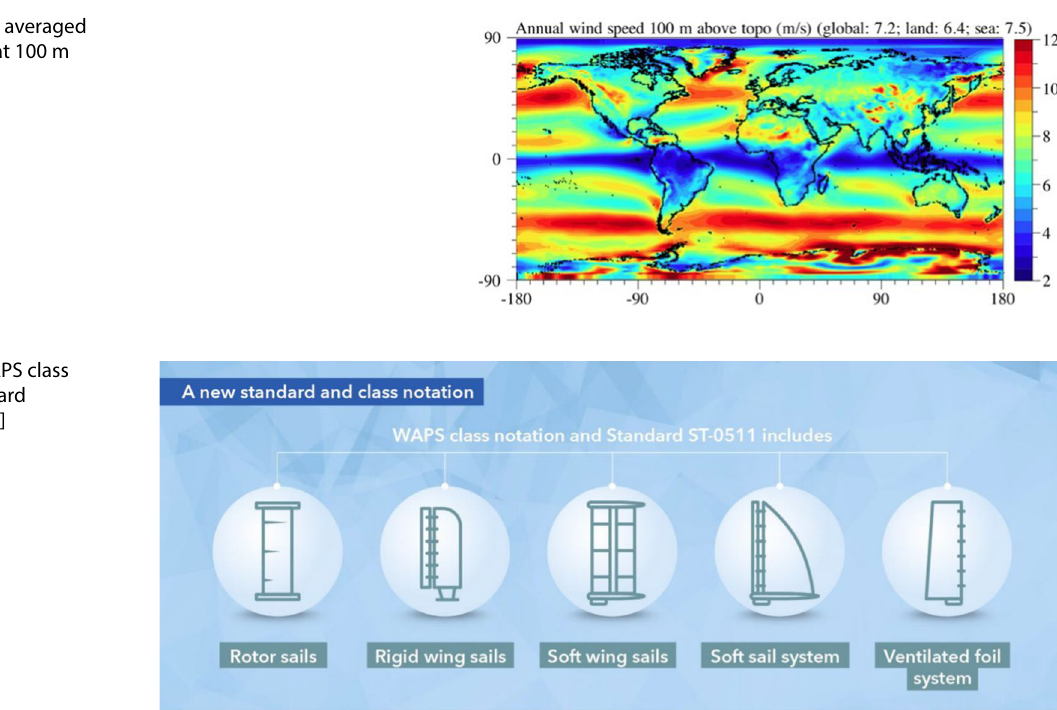
Fig. 2 Global yearly averaged wind speed in m/s at 100 m above sea level [47]